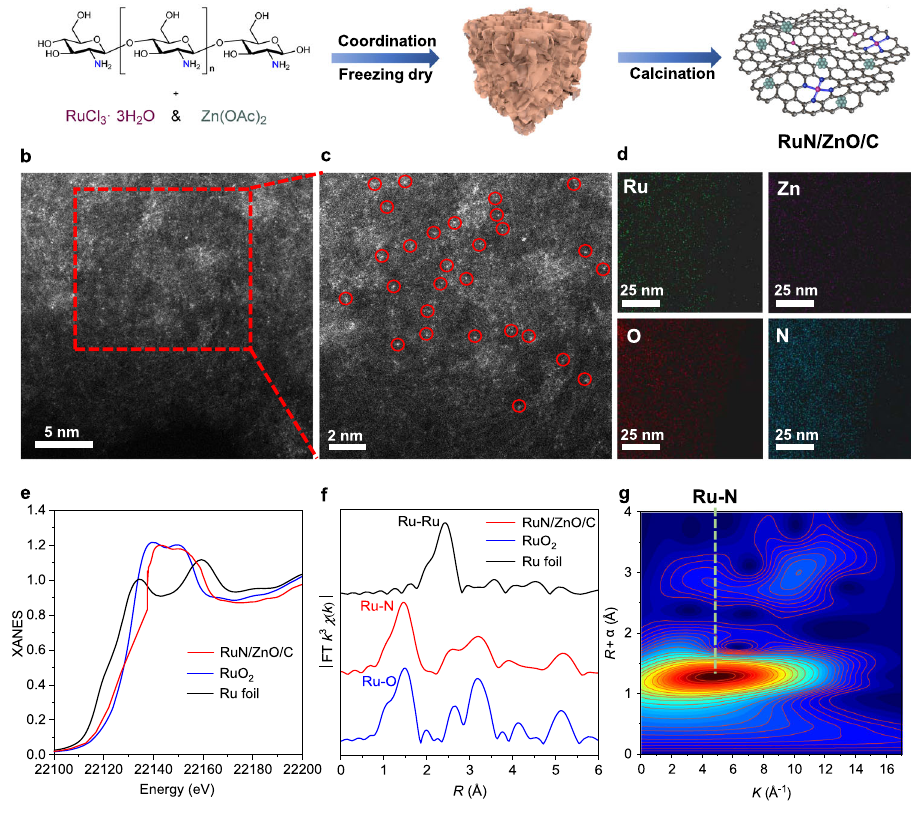
Fig. 2 | Fabrication and characterization of RuN/ZnO/C. a Illustration of the fabricationprocessforRuN/ZnO/Ccatalyst. b , c HAADF-STEMimages, d STEM-EDS